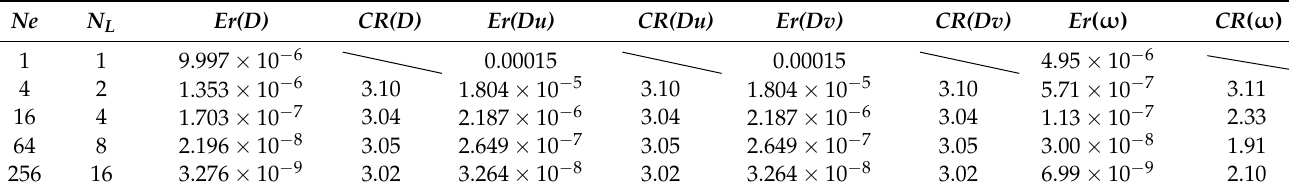
Table 4. N h = N v = 2, the L 2 error of each variable, and the corresponding CR.